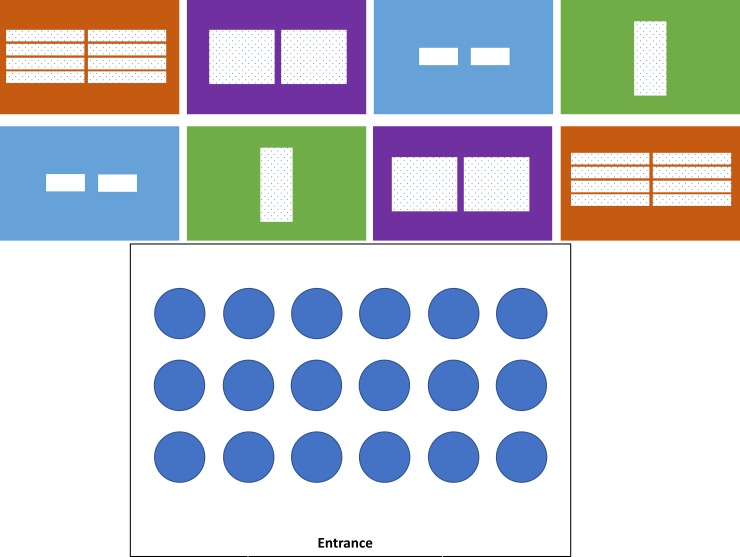
Schematic of experiments to quantify the effect of lighting and genotype used on the growth and morphology of Cannabis mothers.A) Blue, red, purple and green rectangles represent the plasma, T5, Metal Halide and Metal Halide tents, respectively. White squares within each tent represent the approximate size and placement of lamp fixtures. B) Plant layout within each experimental tent.